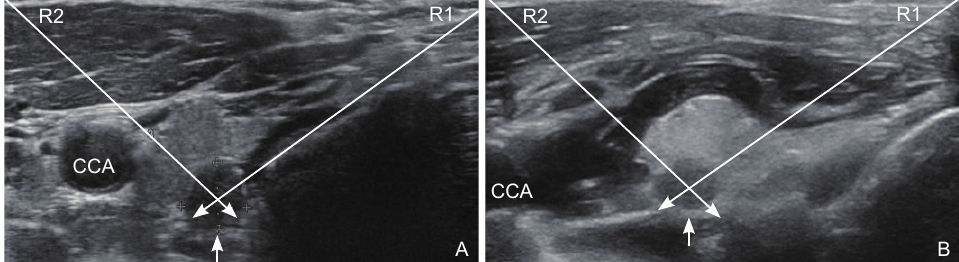
Figure 19 Liquid isolation can optimize the puncture path of FNA. (A) The target nodule (indicated by the up arrow) is close to thyroid cartilage. The puncture needle is more likely to injure the anterior capsular branch of superior thyroid artery and cartilage through the R1 approach, and the common carotid artery through the R2 approach; (B) With liquid isolation, the distance between the target nodule (indicated by the up arrow) and thyroid cartilage and that between the target nodule and common carotid artery (CCA) are all increased. No matter through the R1 or the R2 route, the puncture needle can avoid injuring the anterior capsular branch of superior thyroid artery, cartilage, and the common carotid artery. R1, puncture route 1, also known as the "interior towards exterior" puncture approach, i.e., puncture needle from the midline of neck towards the lateral side of body.